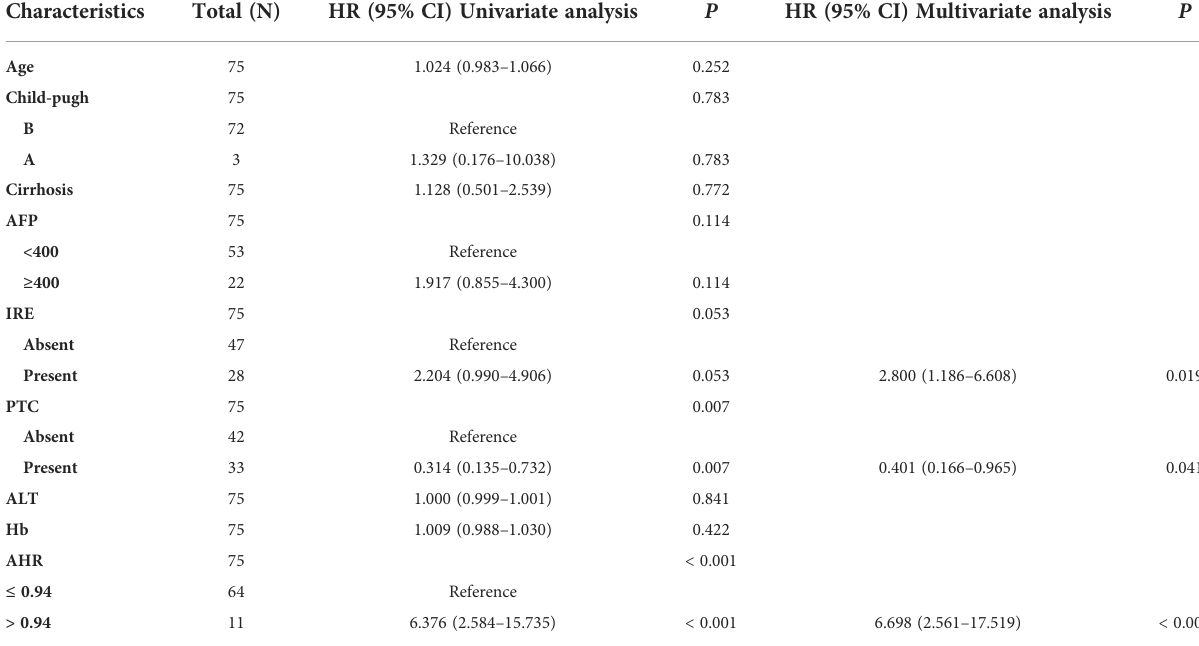
TABLE 3 Univariable and multivariable Cox analyses of OS in the training cohort.